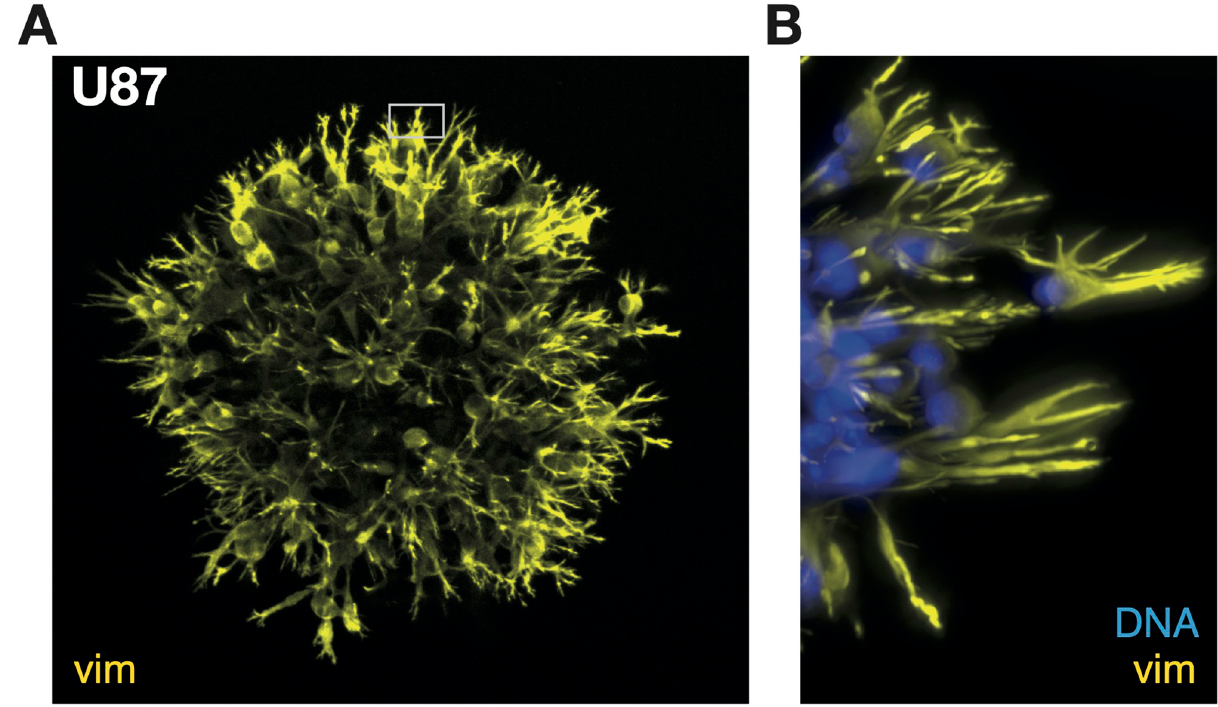
Fig 4. Invasion assay. A: Initiation of invasion for glioblastoma U87in a brain-mimicking matrix. Maximum intensity z-projection of immunofluorescent vim (yellow). B: Merged image of the region of interest in (B) with immunofluorescent vim (yellow) and nuclei stain (blue).